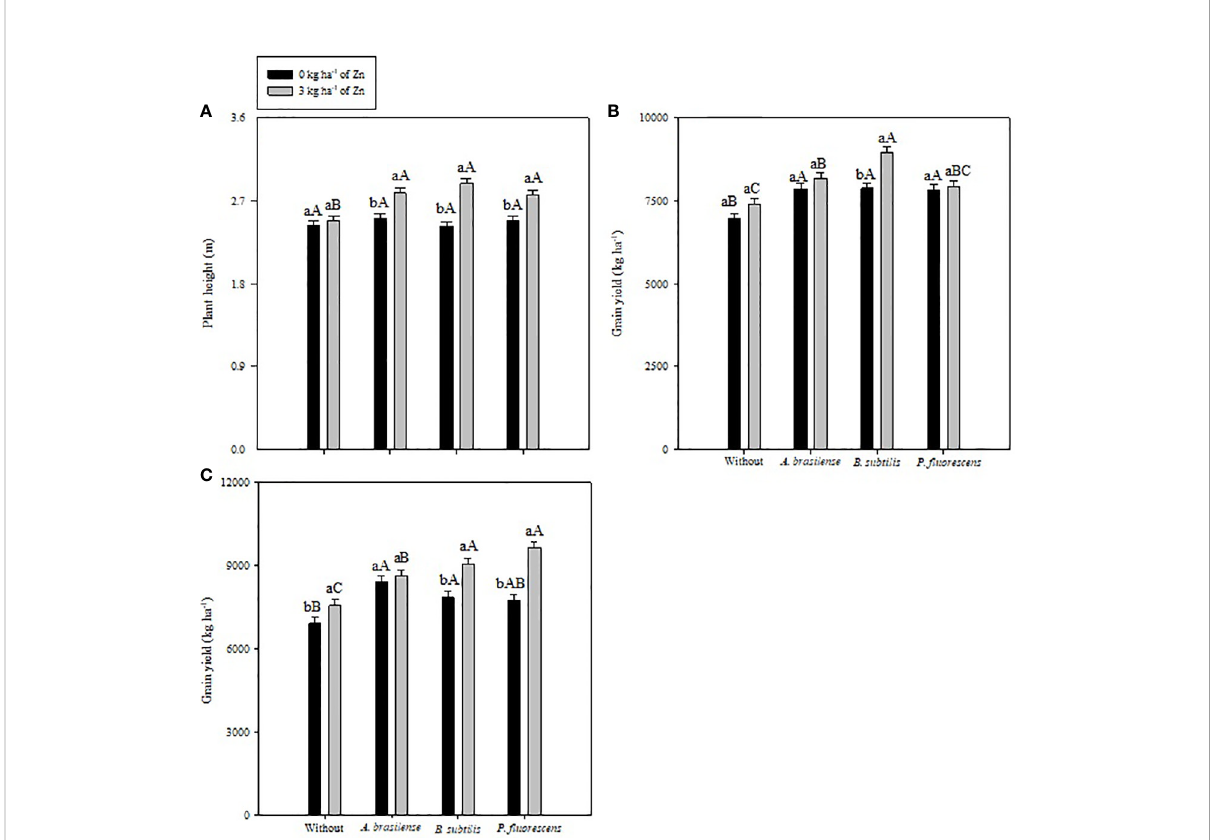
FIGURE 3 Plant height in 2020 – 1 (A) , and grain yield in 2019 – 20 (B) and 2020 – 1 (C) of common bean as a function of plant growth-promoting bacteria in combination with or without foliar nano-zinc oxide (ZnO) application. Without = control (no inoculation). The uppercase letters compare interactions of inoculations within each dose of foliar nano-ZnO application and lowercase letters are used to compare interactions of foliar zinc doses (presence and absence) within each inoculation treatment. The identical alphabetic letters do not differ from each other by Tukey ’ s test ( p < 0.05) for foliar ZnO doses and inoculations in the 2019 – 20 and 2020 – 1 cropping seasons. Error bars indicate standard error of the mean ( n = 4